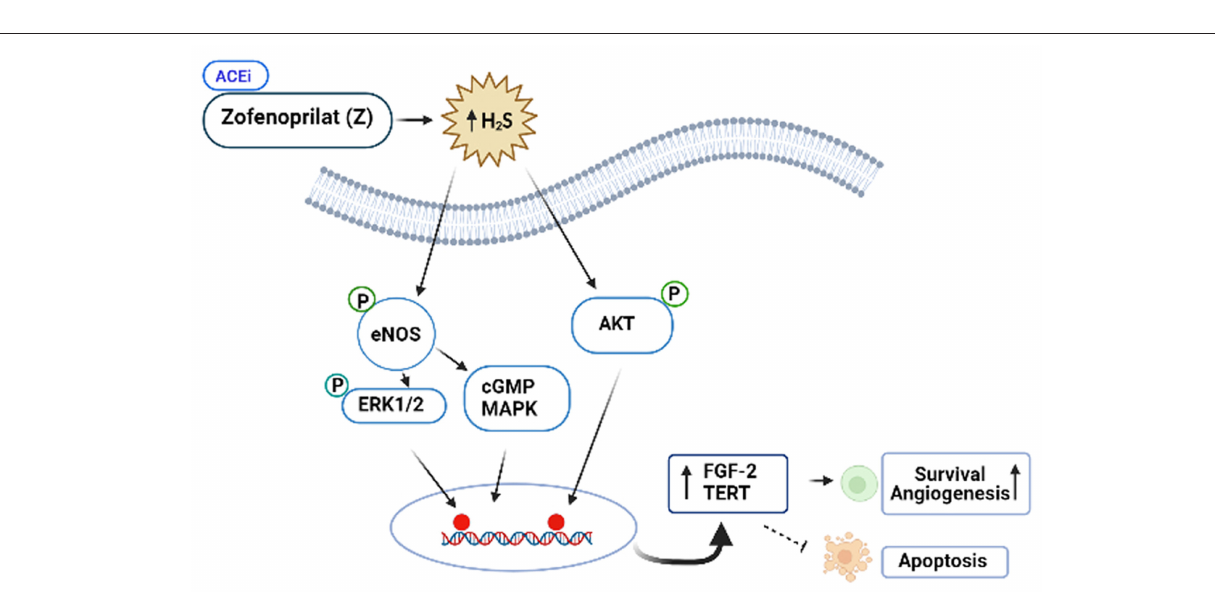
FIGURE 4 | Protective role of the SH-containing ACi, Zofenoprilat, against anticancer-mediated vascular toxicity. Zofenoprilat is the most effective clinically used vascular protectant. It increases survival of ECs and promotes angiogenesis, inhibits apoptosis. The mechanism involves activation of NOS, ERK1/2, cGMP and Akt kinases and increases in the expression levels of fibroblast growth factor (FGF-2) and telomerase reverse transcriptase (TERT). These effects appear to be the off-target effects of zofenoprilat via increasing production of H 2 S, independent of ACEi properties. (3) or PDGF-C (79), leading to worse outcomes of drug delivery, invasion, and metastasis ( Figure 3